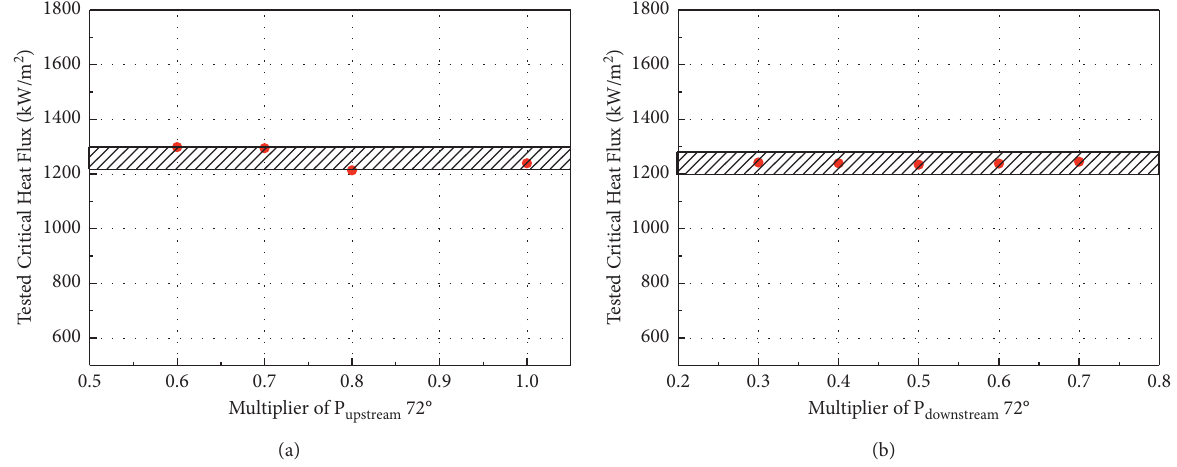
Figure 11: CHF results of upstream and downstream heating power experiments. (a) Test case 2. (b) Test case 3.